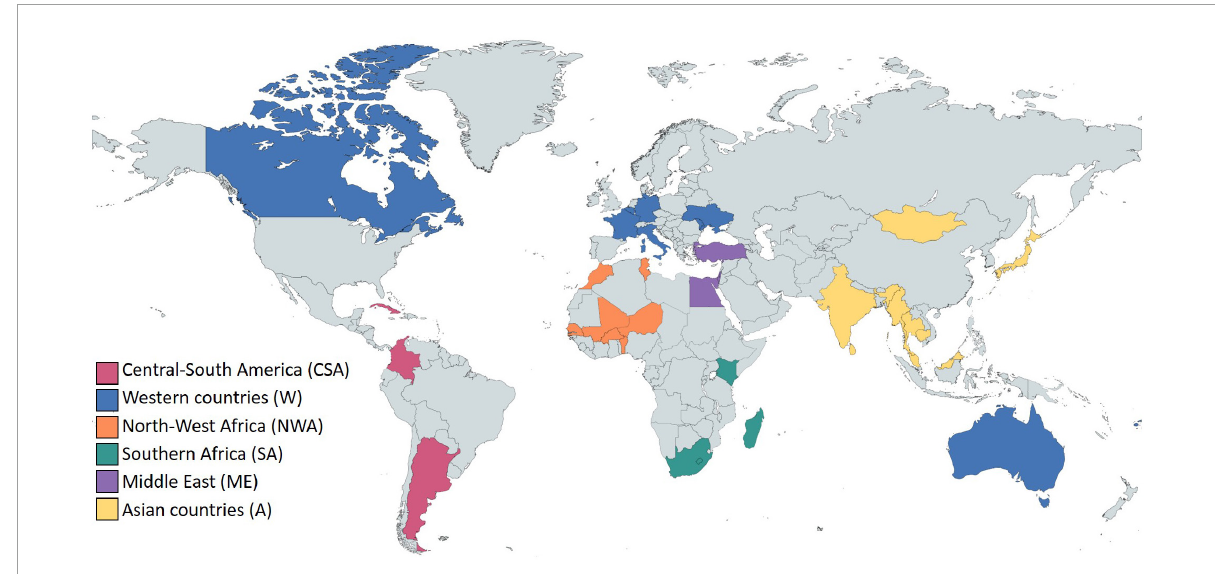
FIGURE4 World map showing the countries and cultures